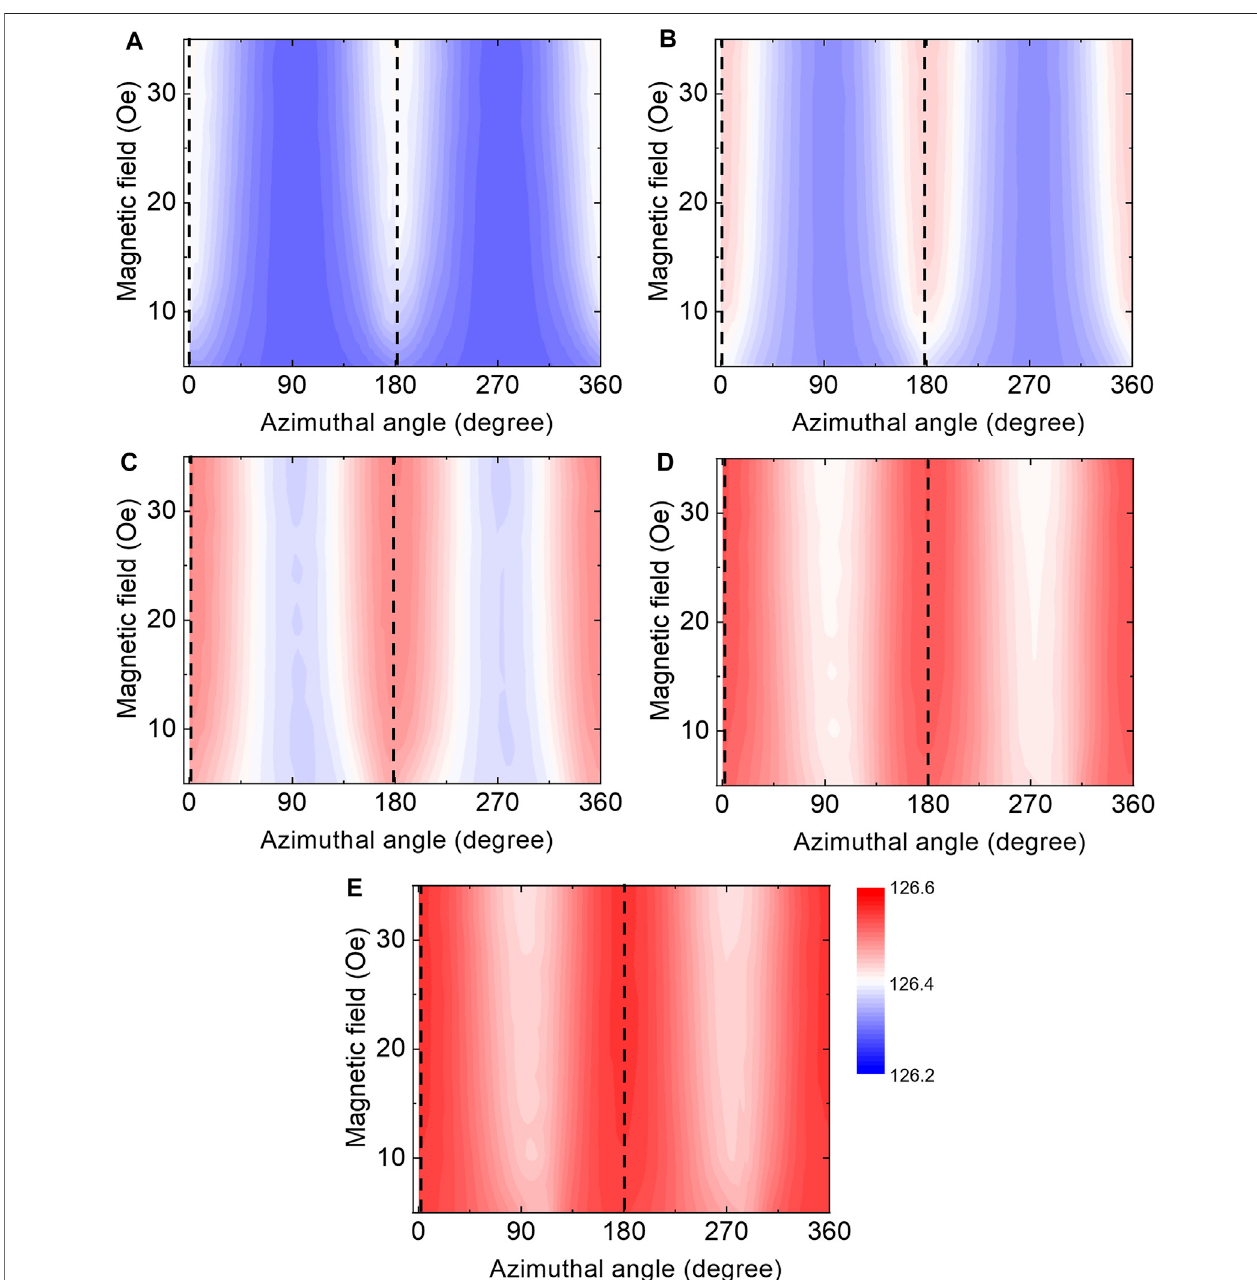
FIGURE 5 | (A – E) CTC mappings under different E- fi eld bias, i.e., 0, 2, 4, 6, and 8 kV/cm, respectively. The dashed lines show the angular position of applied magnetic fi elds with maximum magnetoresistance values. All fi gures use same contour scale with unit Ω .